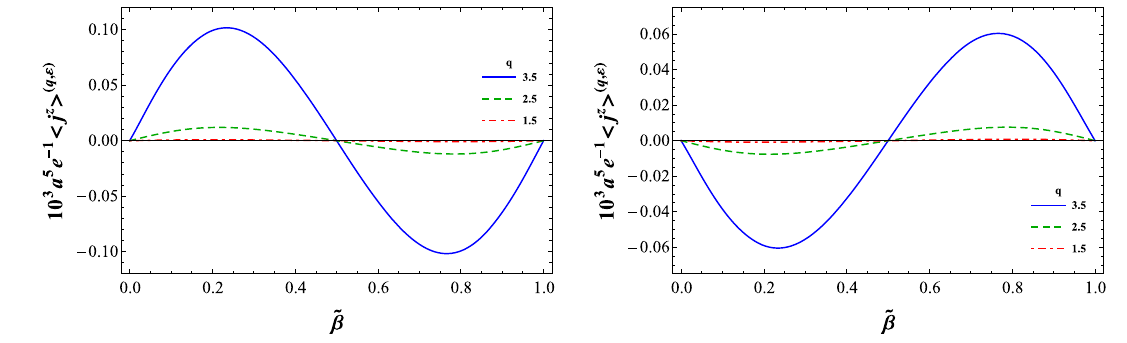
Fig. 5 The VEV of the axial current induced by the compactification in Eq. (4.12) is plotted, in units of a 5 e − 1 , as function of ˜ β for q = 2 . 5, r /w = 1 and ma = 5. In the left plot, we consider α 0 = 0, while in the right plot, we take α 0 = 0 . 35